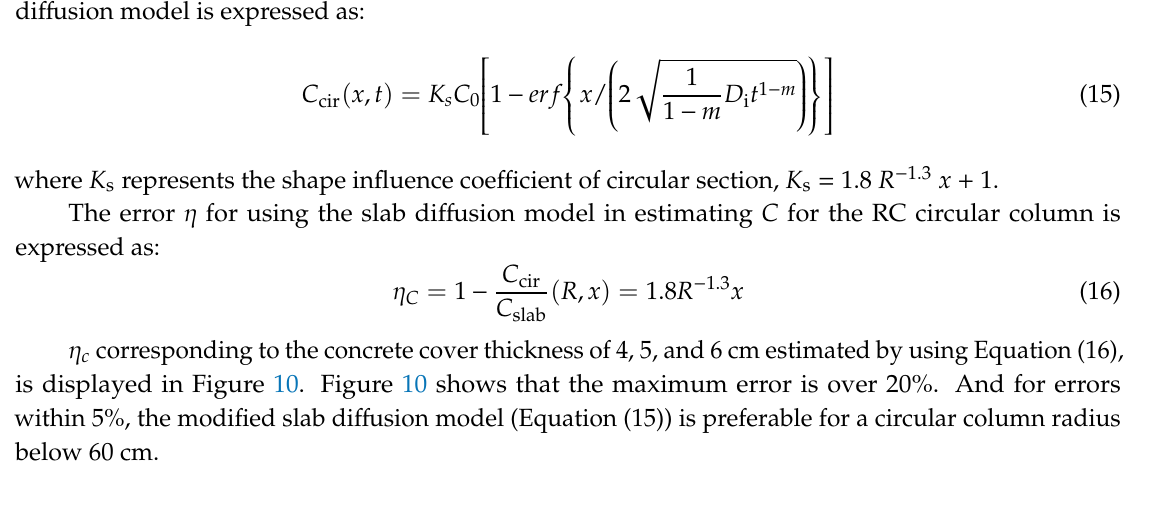
Figure 9. Plot of the concrete b versus radius.